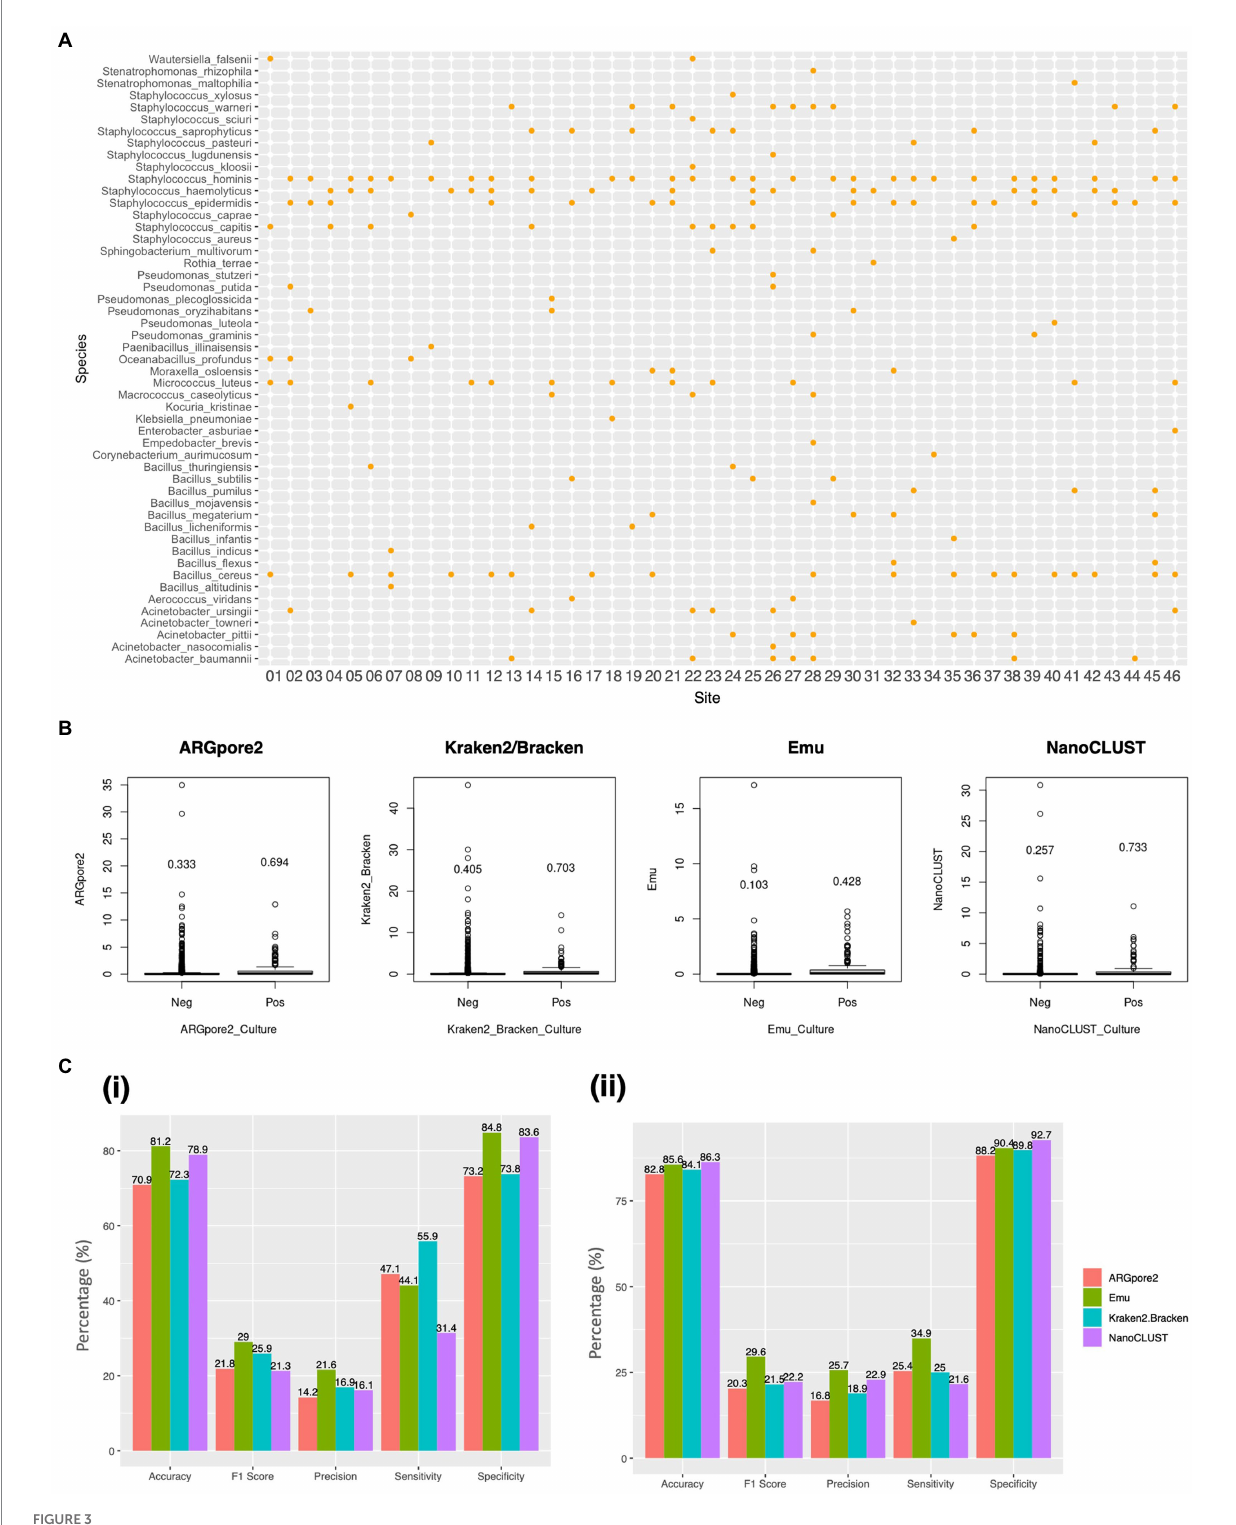
FIGURE 3 Comparisons of bacterial species identified by conventional culture and the four classifiers. (A) Bacterial presence in routine culture from the 46 urban samples. Each dot represents at least one colony that has been identified. (B) Species classified by ARGpore2, Emu, Kraken2/Bracken, and NanoCLUST were present (Pos) and absent (Neg) in culture. The y-axis represents the abundance of the classified species, and the values were the abundance means. (C) Bar plots of average accuracy, precision, sensitivity, specificity, and F1 score of the four classifiers based on the species present in culture using (i) 0.1% and (ii) mean abundance of the detectable species in MegaBLAST as the